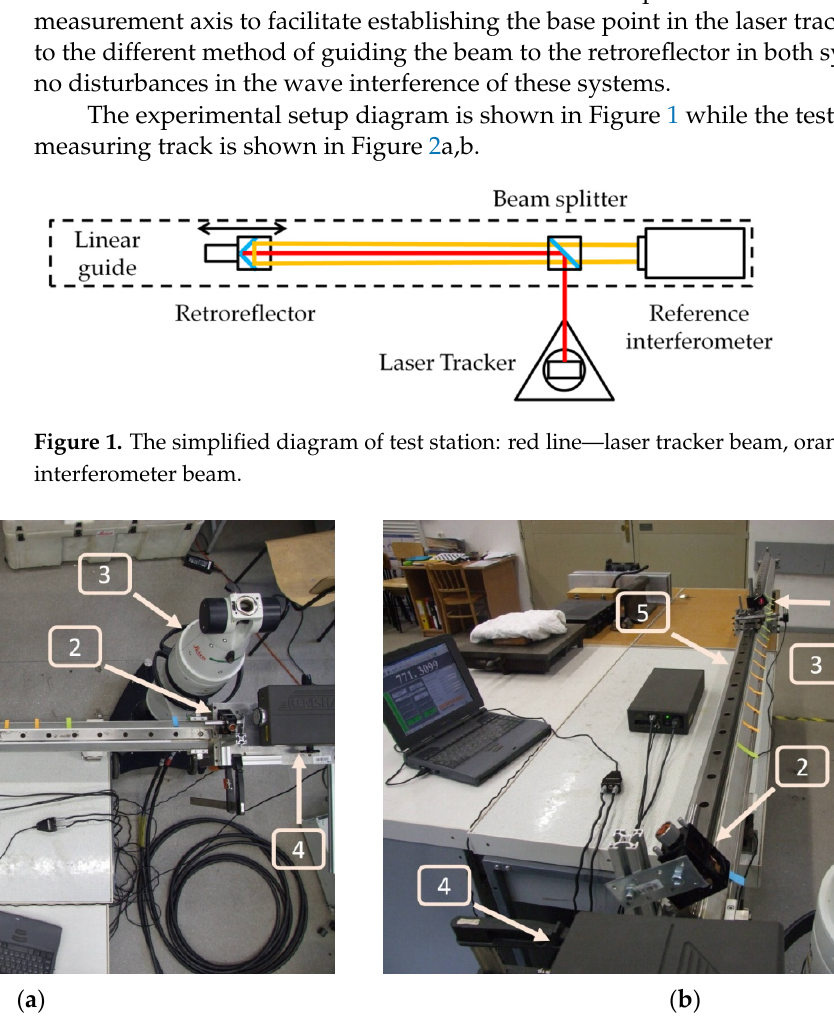
Figure 2. Test station—retroreflector (1), beam splitter (2), tested system (3), reference system (4) and linear guide (5); ( a ) top view; ( b ) view from the reference system side.